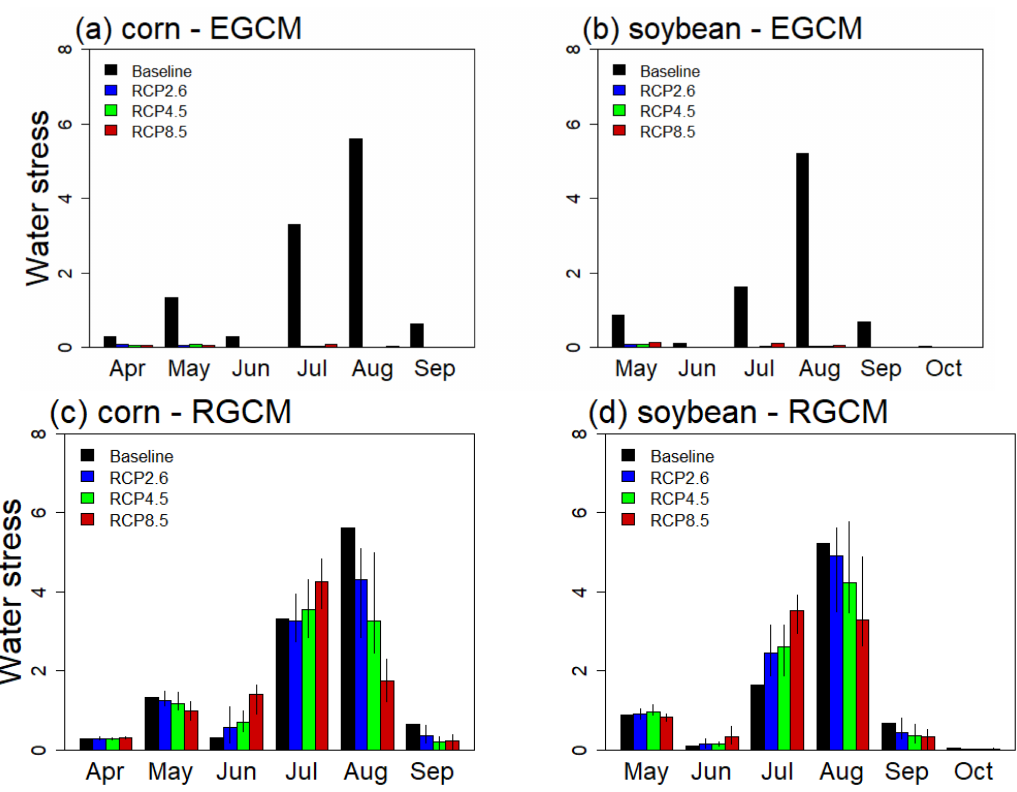
Figure 8. Daily average of cumulative solar radiation and monthly average water stress for corn and soybean.